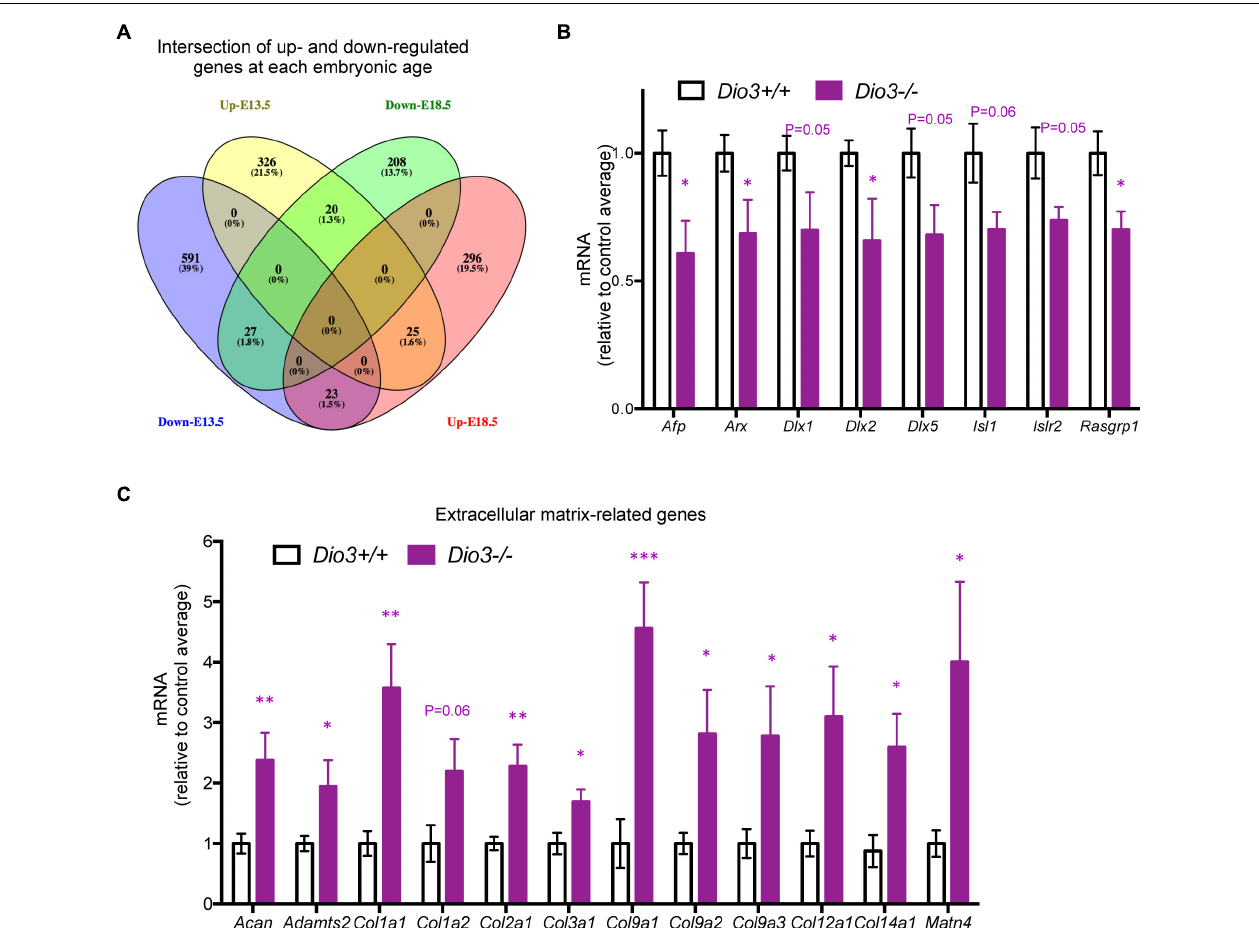
FIGURE 7 | Overlap and differential gene expression in E13.5 Dio3 − / − brains. (A) Venn diagram of up- and down regulated genes in Dio3 − / − brain at E13.5 and E18.5. (B) qPCR validation of additional DEGs that are down-regulated in E13.5 Dio3 − / − brains. (C) qPCR validation of differential expression of genes related to extracellular matrix components in E13.5 Dio3 − / − brains. Data represent the mean ± SEM, relative to control mean value, of 8 and 6 different samples from E18.5 Dio3 + / + and Dio3 − / − mice. ∗ , ∗∗ , and ∗∗∗ , indicate p < 0.05, p < 0.01, and p < 0.001, respectively, E13.5 vs E18.5 as determined by the Student’s t